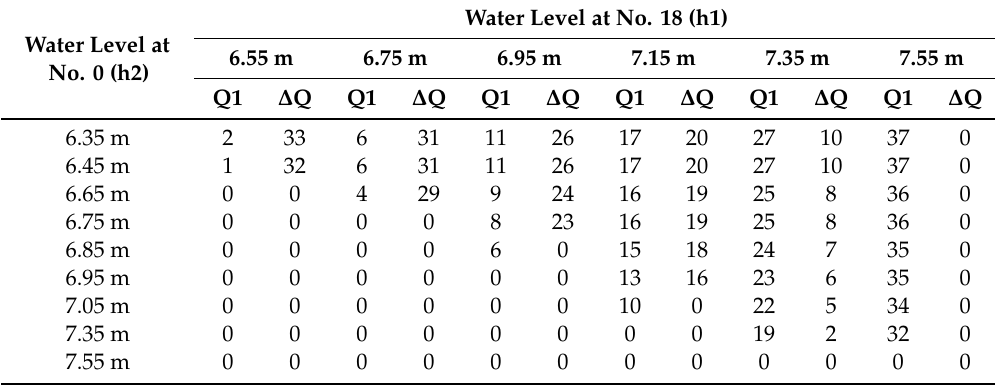
Table 4. Discharge conditions at point No. 18 for caution warning criteria (unit: m 3 / s).